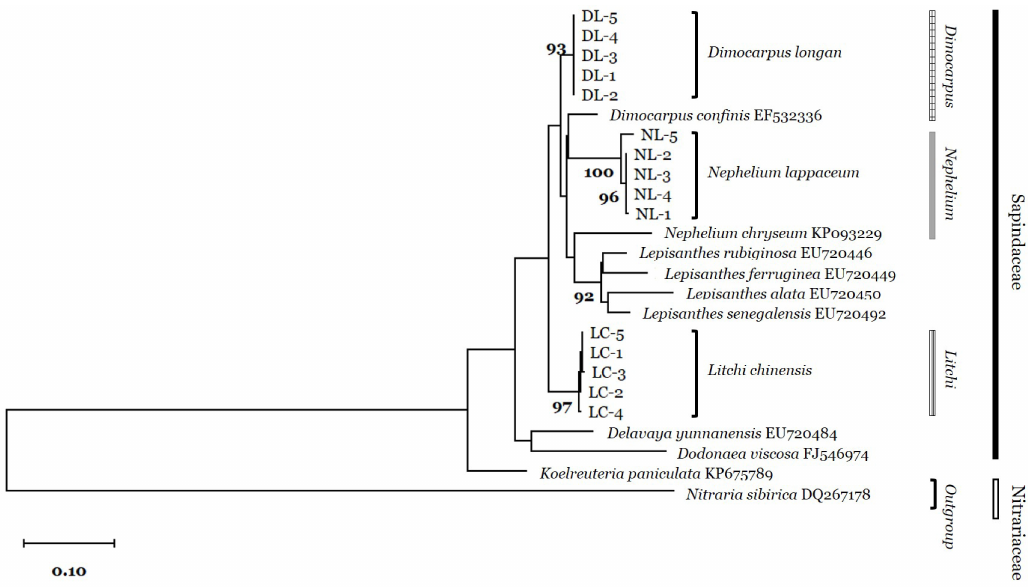
Figure 1. Neighbor-joining (NJ) tree based on ITS sequences for D. longan , L. chinensis , N. lappaceum , and nine closely related species in Sapindaceae. The NJ tree was obtained using MEGAX with 1000 bootstrap replicates. Scale bar represents 0.10 substitutions per site.